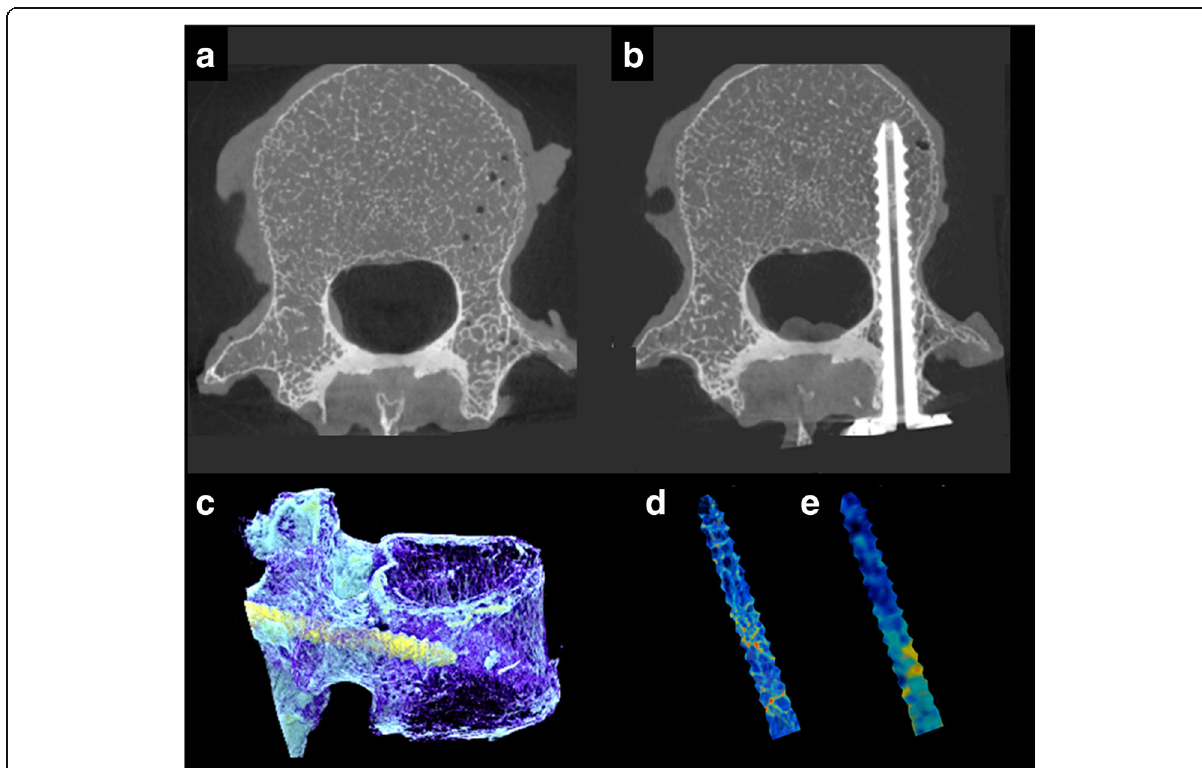
Fig. 3 Micro-CT and MSCT imaging. a Micro-CT axial image of a vertebra. b Micro-CT axial image of a vertebra with a screw. c Three-dimensional micro-CT reconstruction of a vertebra with a screw. Cancellous bone area of the pedicle screw extracted by three-dimensional volume position adjustment between the pre- and post-insertion images: micro-CT ( d ) and MSCT ( e